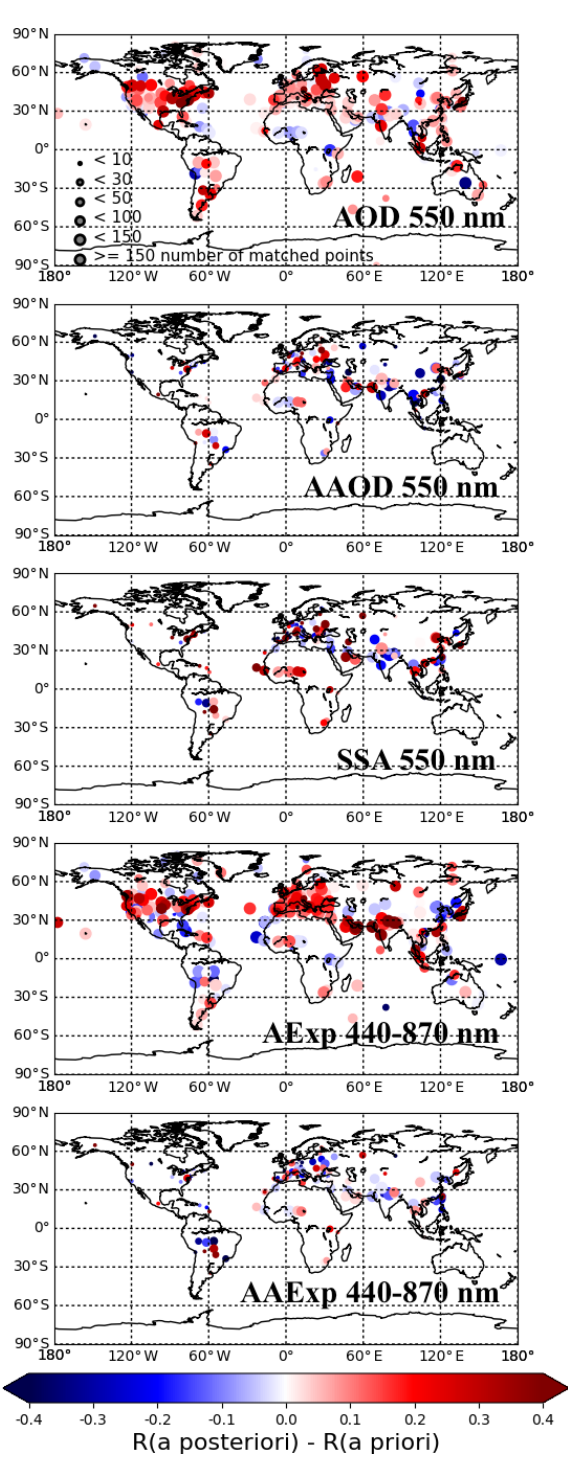
Figure 7. The differences between a posteriori and a priori GEOS- Chem simulated AOD, AAOD, SSA, AExp and AAExp correla- tion coefficients ( R ) with AERONET daily aerosol products over all sites with colocated data in